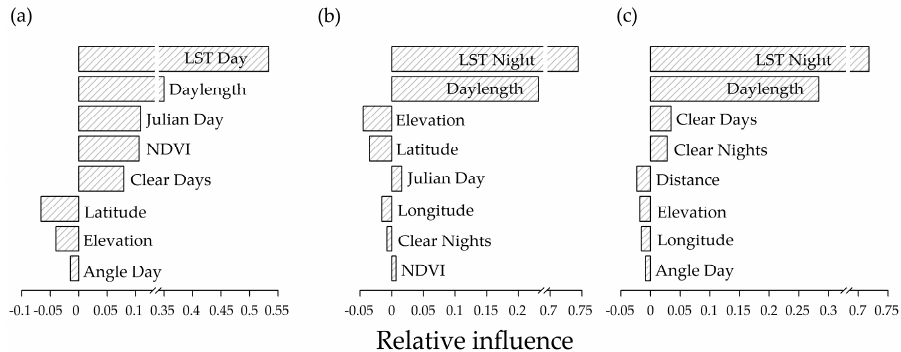
Figure 3. Independent variable’s standardized regression coefficient for estimating air temperature, ( a ) T max , ( b ) T min , and ( c ) T mean .